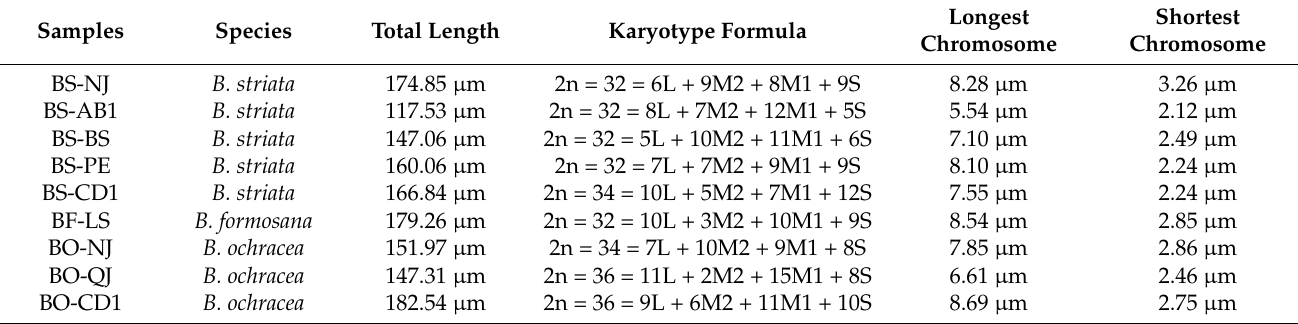
Table 4. Karyotype analysis of sixteen samples in Bletilla